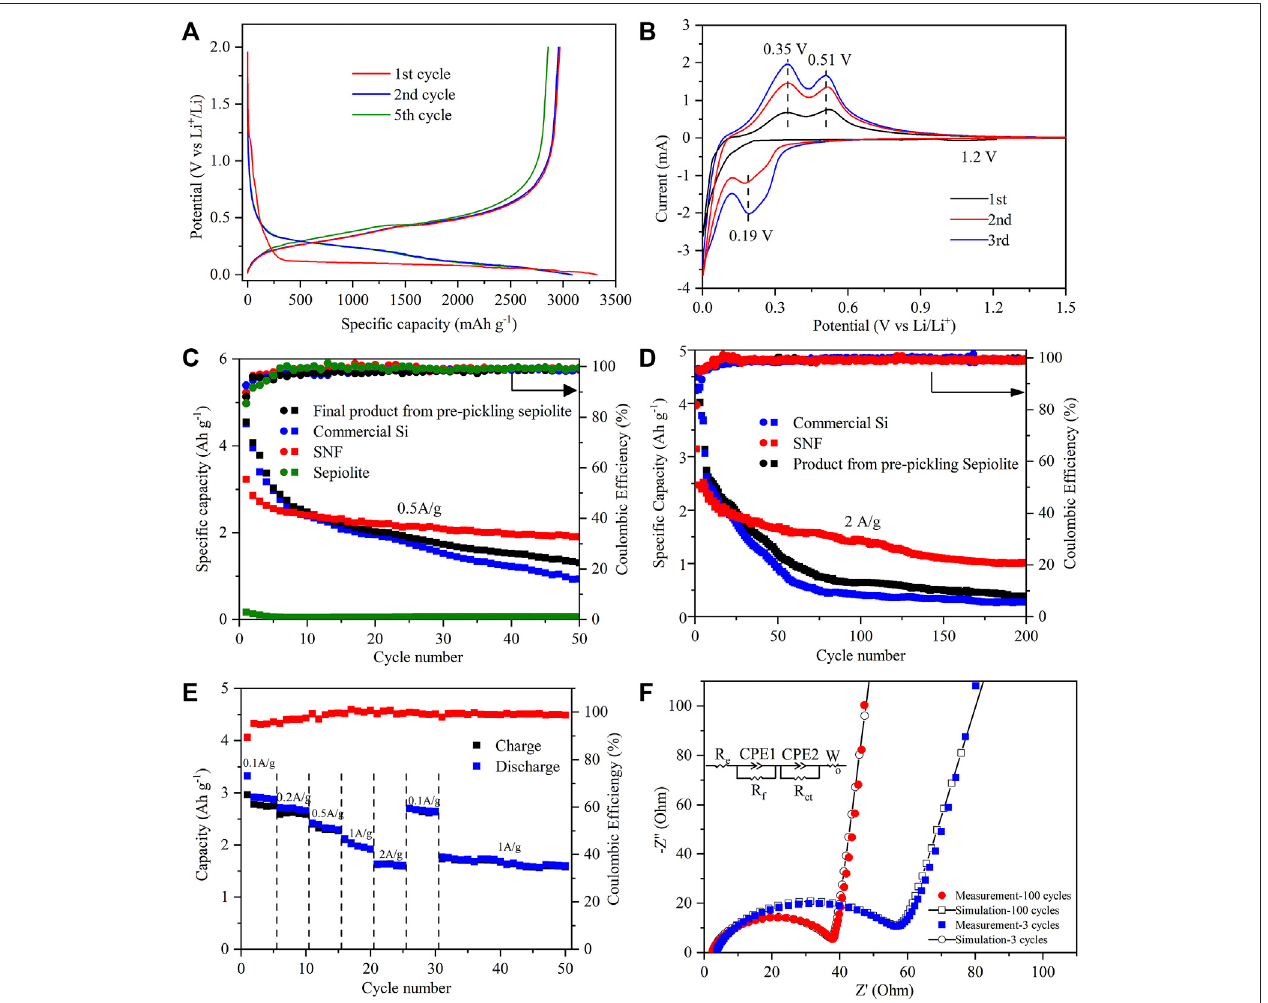
FIGURE6|(A) Charge – dischargecurvesofSNFatacurrentdensityof0.5 A g − 1 between0.001and2 V(vs.Li/Li + ). (B) Cyclicvoltammetrycurvesatascanrateof 0.1 mV s − 1 inthe voltage range of 0.001 – 1.5 V ofSNF for the fi rst three cycles.Long-term cyclingcomparison ofdifferent products at (C) 0.5 A g − 1 and (D) 2 A g − 1 . (E) Rate capabilities at various current densities from 0.1 to 2 A g − 1 and (F) measured points with calculated lines for the impedance after 3 and 100 cycles at 2.0 A g − 1 of